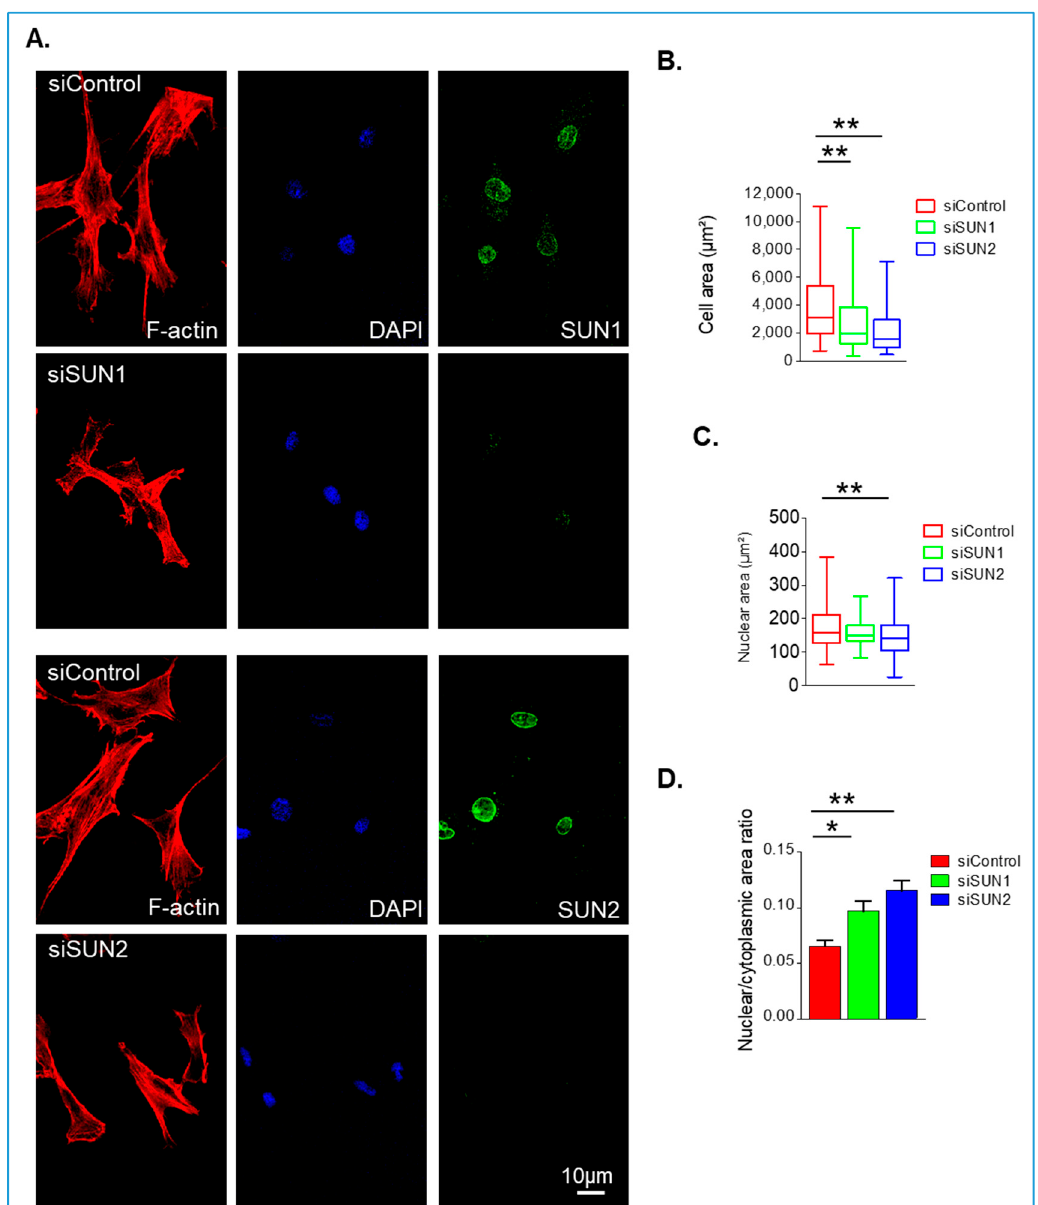
Figure 2. SUN1 and SUN2 influence isolated VSMCs spreading. ( A ) Representative confocal immunofluorescence microscopy images of rhodamine phalloidin (red), SUN1 or SUN2 (green), and DAPI (blue) stained VSMCs grown on 12 kPa hydrogels. Graphs show IF analysis of ( B ) cell area, ( C ) nuclear area, and ( D ) nuclear area:cytoplasmic area ratio of control, SUN1- and SUN2-depleted VSMCs. Graphs represent combined data of three independent experiments analysing >300 cells per group (* p < 0.05 and ** p < 0.01).